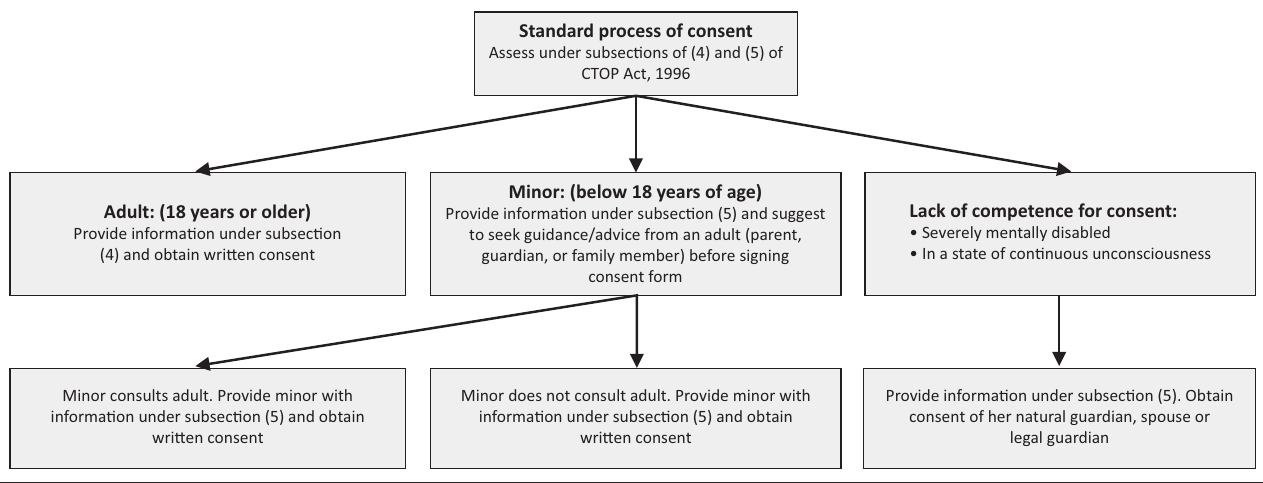
FIGURE 2: Standard process of consent for termination of pregnancy under the Choice on Termination of Pregnancy Act 92 ,